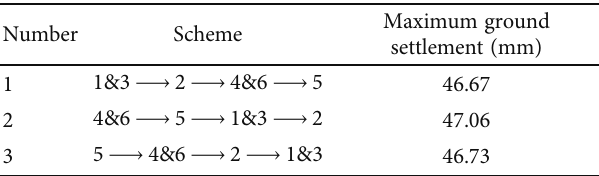
Figure 12: Pilot tunnel number. Table 3: Ground subsidence of di ff erent pilot tunnel excavation